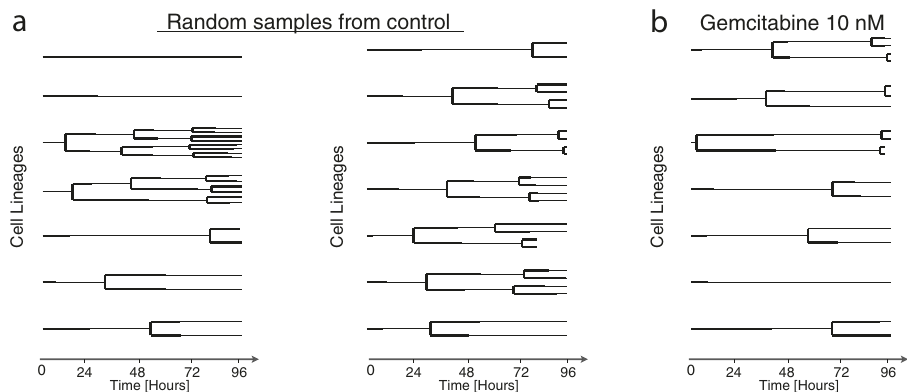
Fig. 1 Total cell number is insuf fi cient to distinguish the structure of heterogeneous populations. a Randomly sampled lineages of untreated AU565 cells from the same replicate and experiment. b Randomly sampled lineages of AU565 cells treated with 5 nM gemcitabine from a single replicate and experiment. Each line indicates the lifetime of one cell. A line branching into two lines indicates cell division. The G1 and S/G2 phase durations are indicated by solid thick and thin lines, respectively.